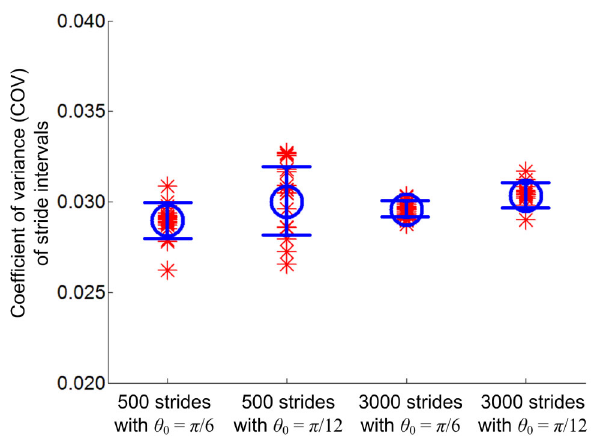
Figure 9. Distribution of coefficient of variance (COV). In both cases of h 0 = p /6 and h 0 = p /12, the distribution of COV obtained from each set of 500 or 3,000 strides is not significantly different from 3%, the COV of stride intervals observed in normal human walking. The circle and error bar indicate the mean and the standard deviation interval,